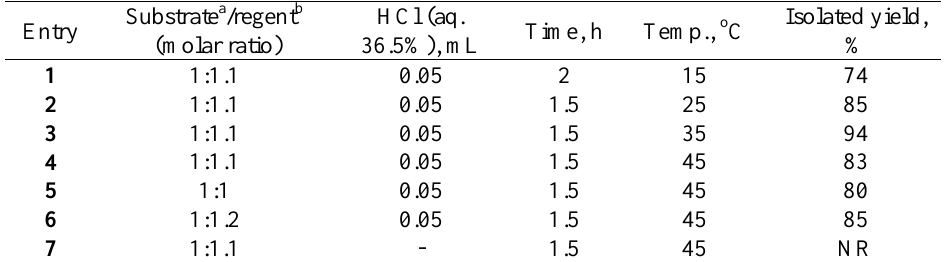
Table 1. The effect of reaction conditions on the yield of 2a under ultrasound